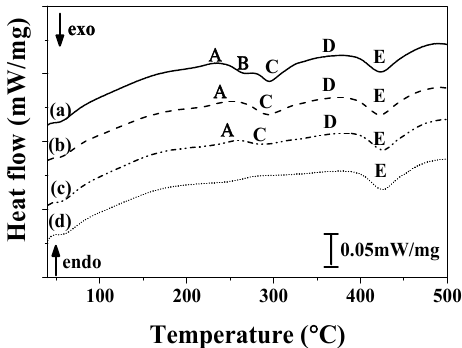
Figure 8. The heat flow curves of Al-1.1Mg2Si samples according to increase of aging treatment temperature: ( a ) 180 ◦ C, ( b ) 200 ◦ C, ( c ) 220 ◦ C, and ( d ) 240 ◦ C. temperature: ( a ) 180 °C, ( b ) 200 °C, ( c ) 220 °C, and ( d ) 240 °C.